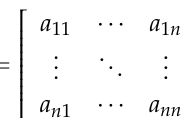
Figure 3. Procedure of repetition-based cooperative broadcasting (RBCB) scheme: ( a ) initial broadcasting,